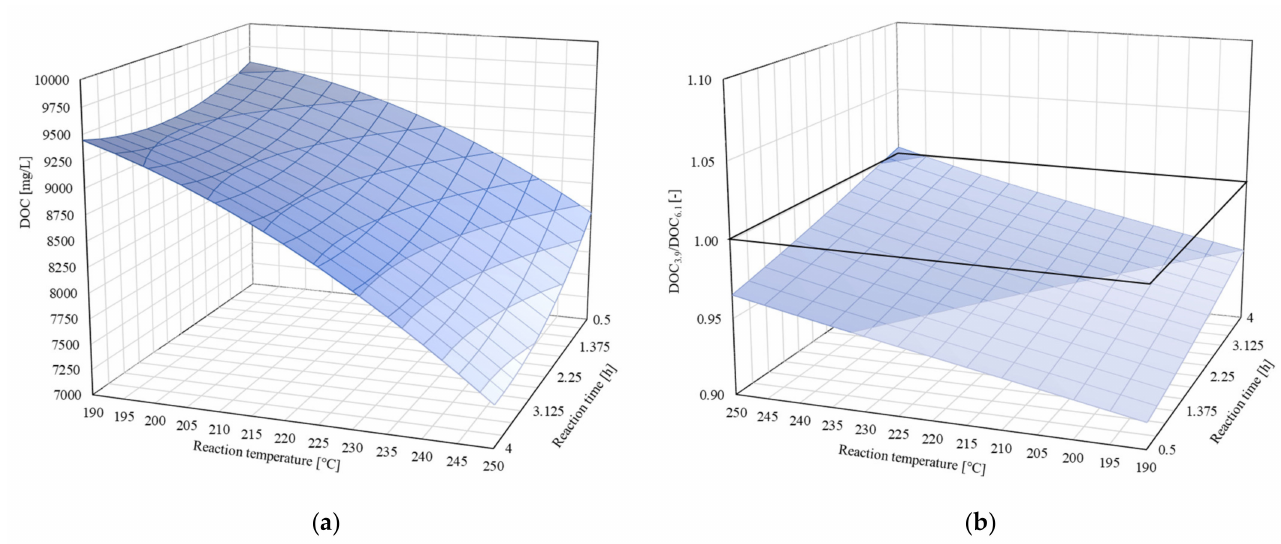
Figure 2. Response surface plots for ( a ) DOC at pH = 6.1 and ( b ) the effect of different pH on the DOC